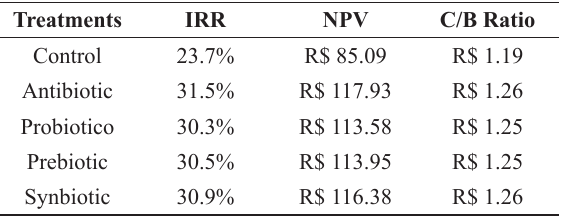
Financial analysis using different additives in the feed of Japanese quails throughout the productive period (9 to 39 weeks of